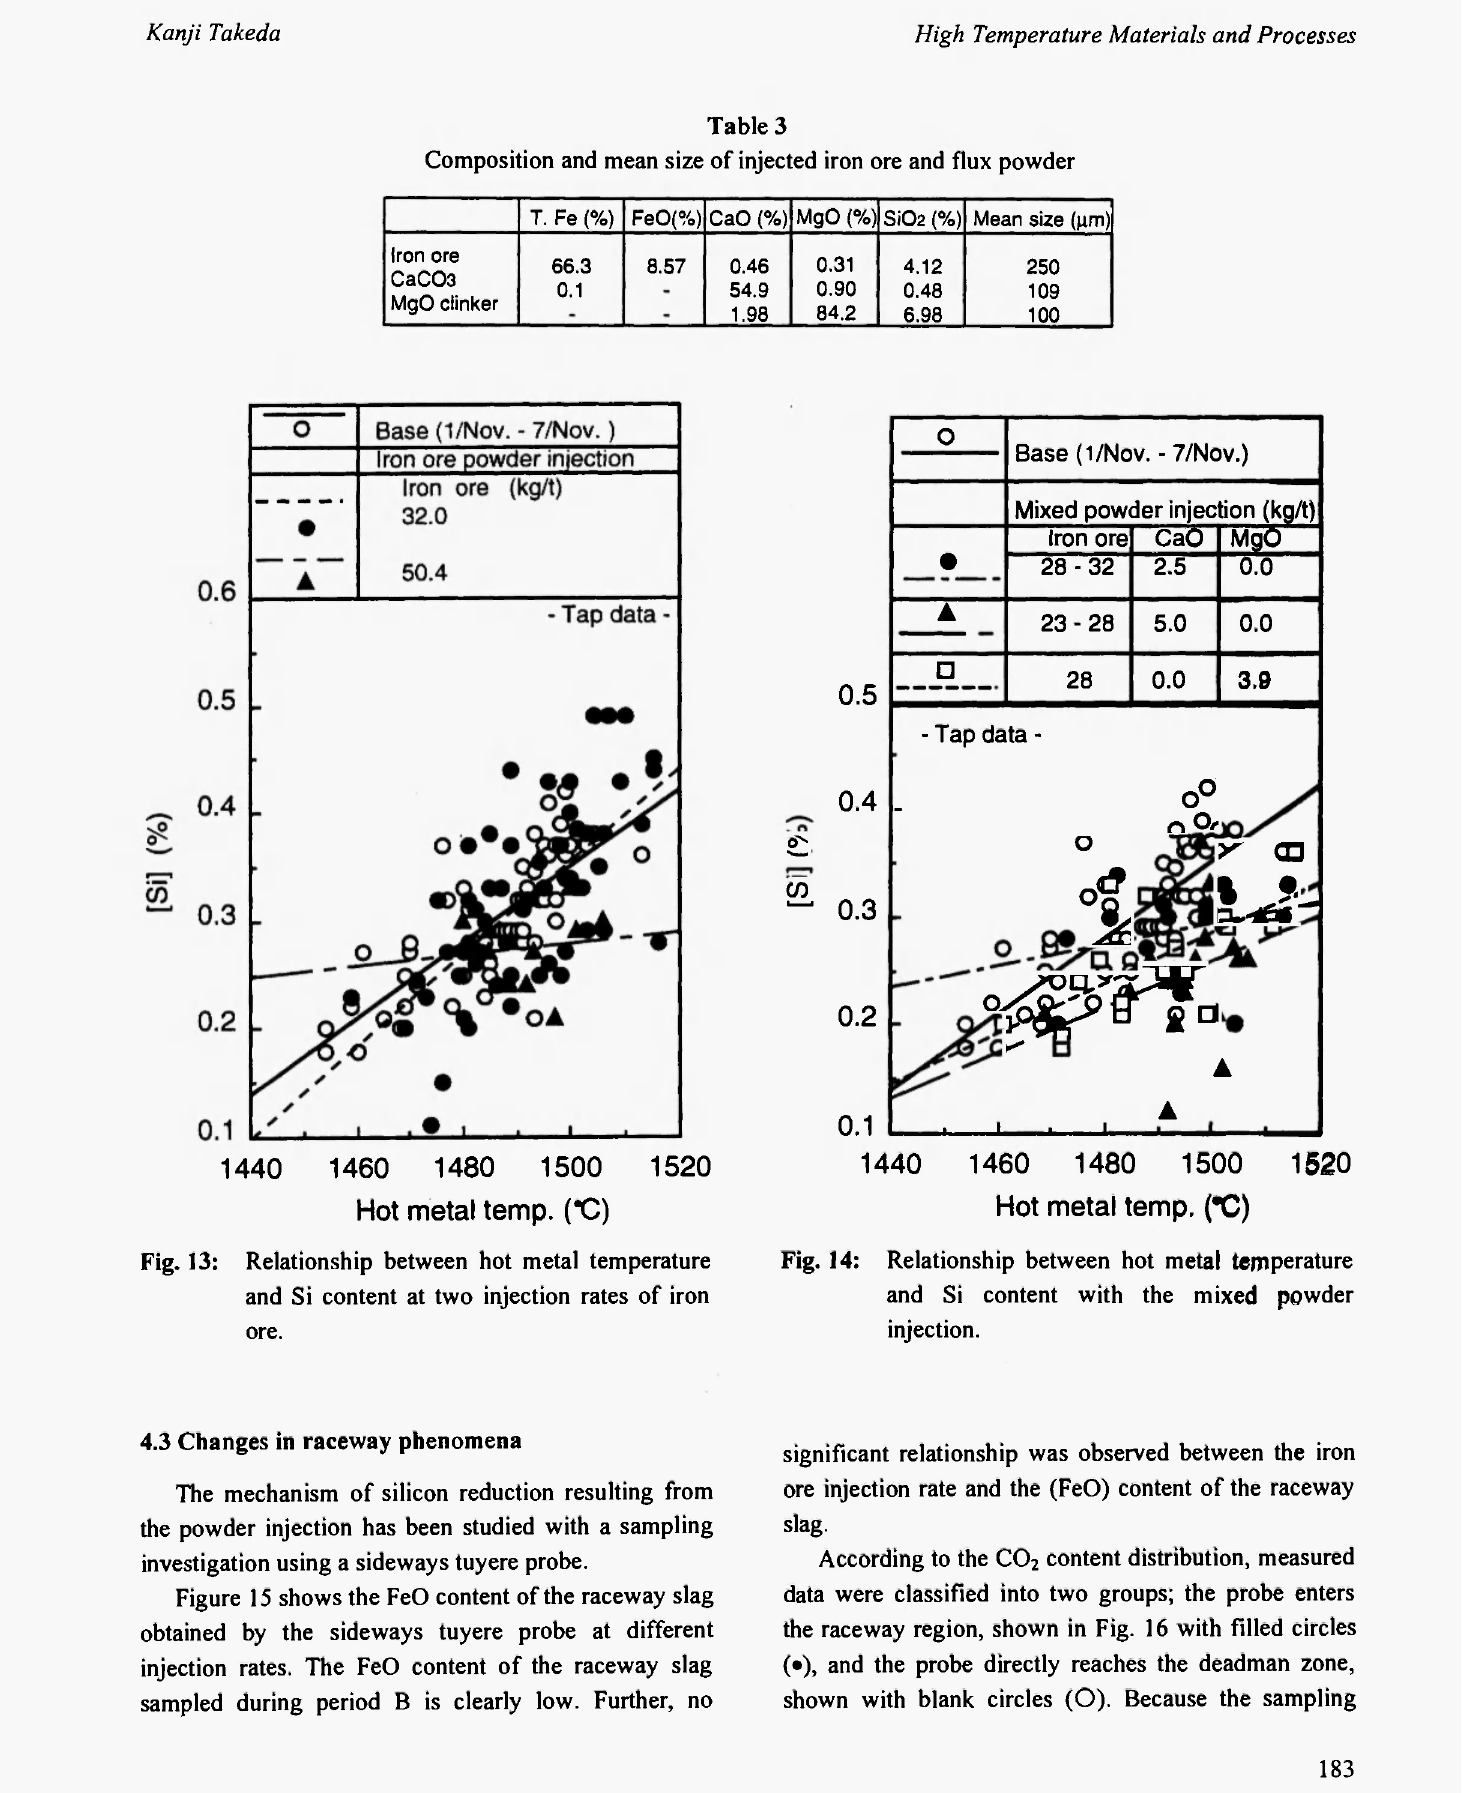
Composition and mean size of injected iron ore and flux powder